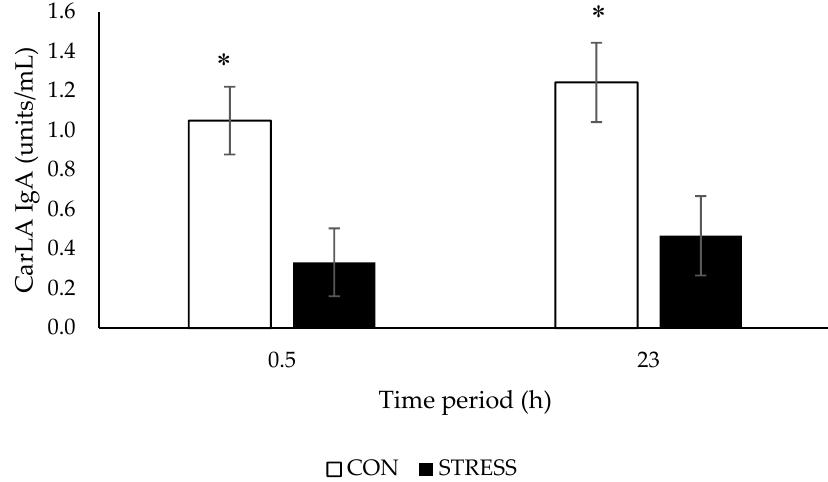
Figure 2. CarLA concentrations (units/mL; means ± SED) of ewes housed in control (CON) or visually isolated pens (STRESS) after a 0.5 h and a 23 h test period. * For a time period, least square means differ at p < 0.05 (back-transformed means).